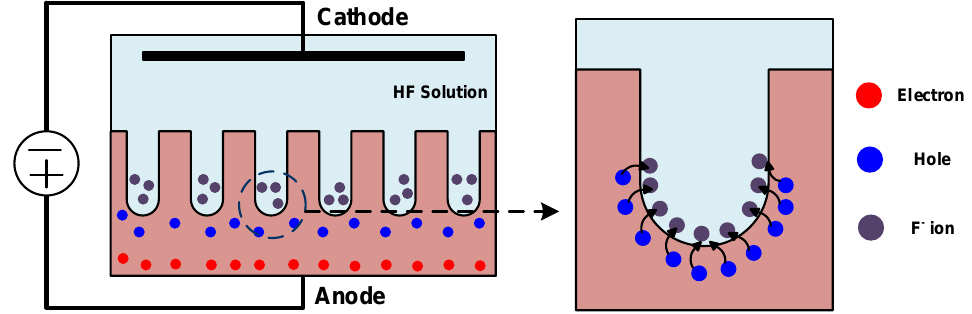
Figure 4. Experimental setup of the anodic electrochemical etching method to form the porous Si.